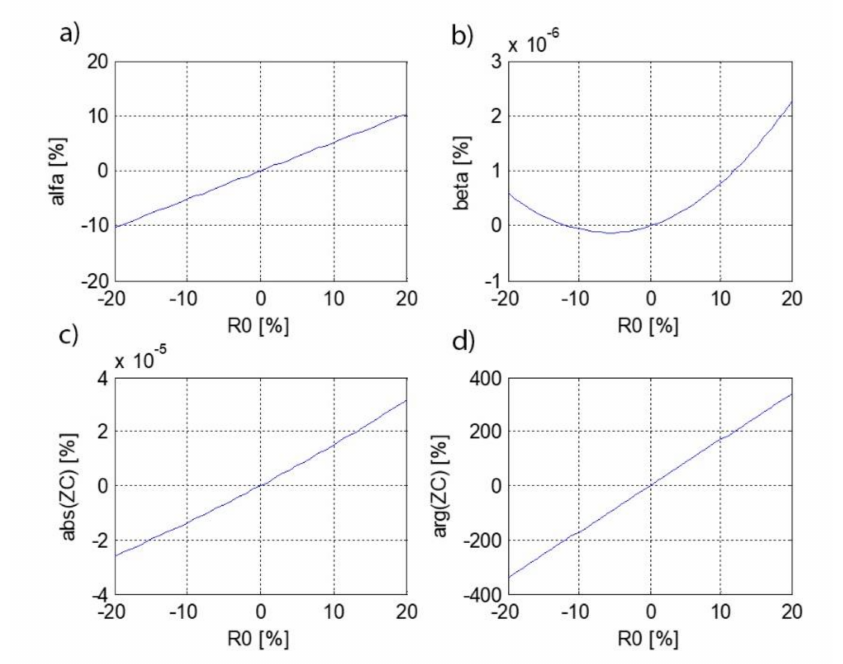
Figure 3. Changes of wave parameters depending on R 0 at f = 500 kHz; ( a ) damping factor α ,